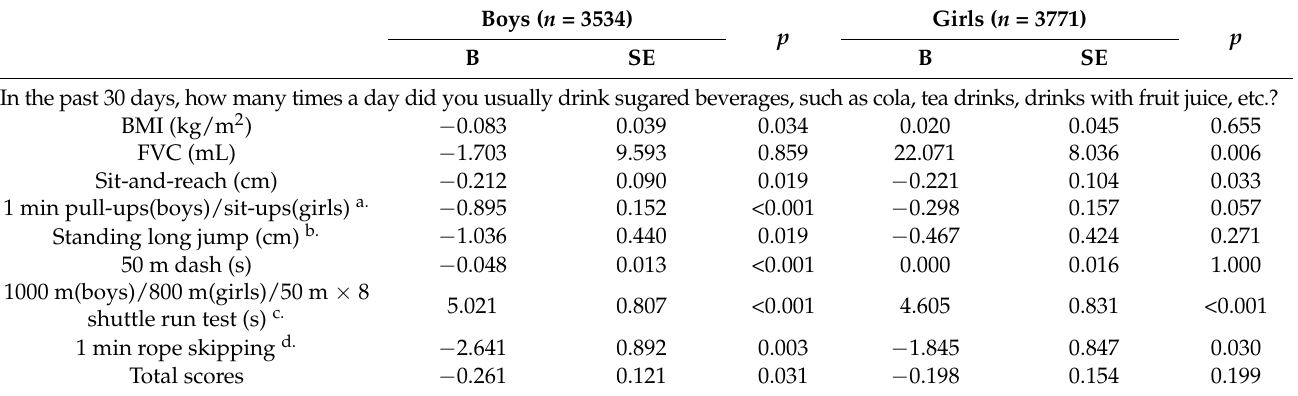
Table 6. Association between frequency of sugared beverage intake and physical fitness in children and adolescents. Boys ( n =